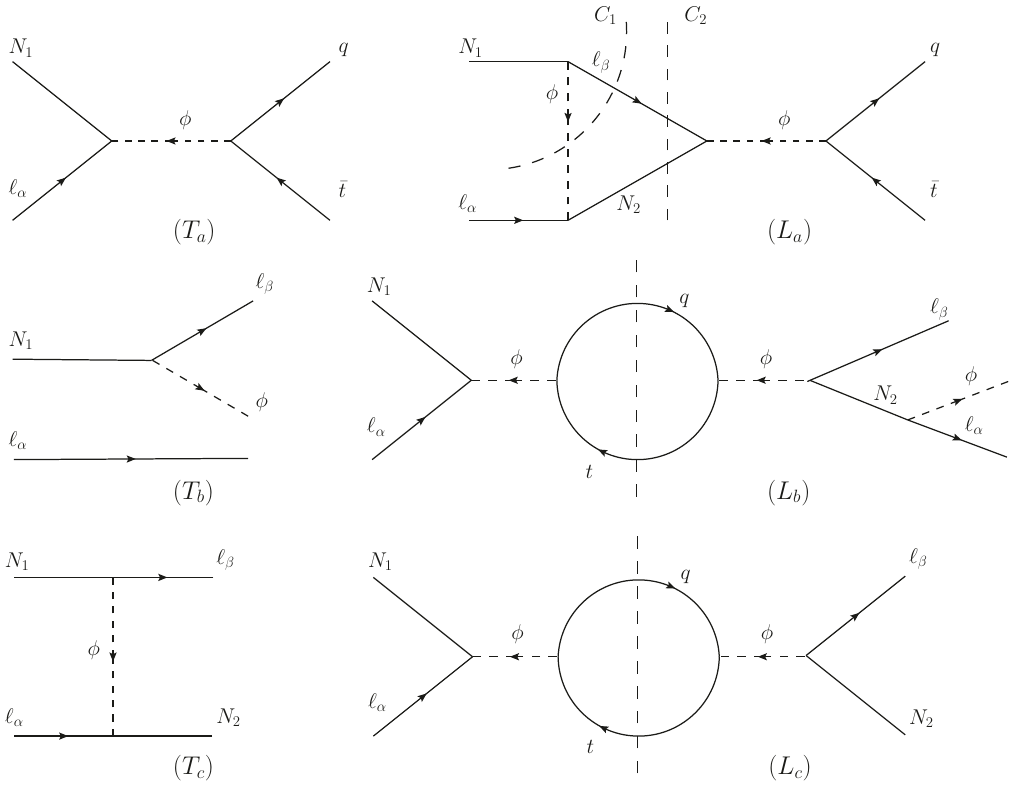
2 . Tree-level and one-loop (cid:1) A ( N 1 ‘ (cid:11) f ) f j ! j